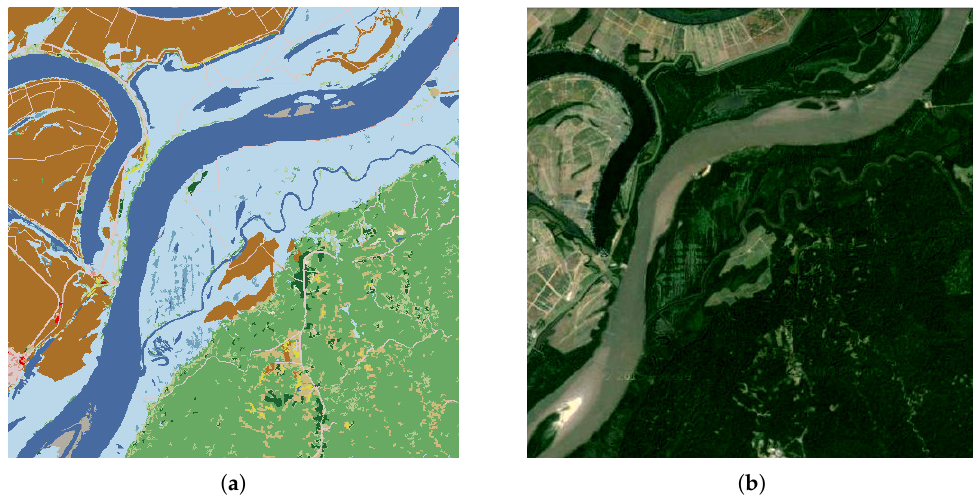
Figure 11. Reference scene II over Yucatan Lake in Louisiana. ( a ) The scene in NLCD 2006; ( b ) The remotely sensed image taken from Google Earth on the same region of the reference scene shown in ( a ) (for visualization, the histogram of the image has been